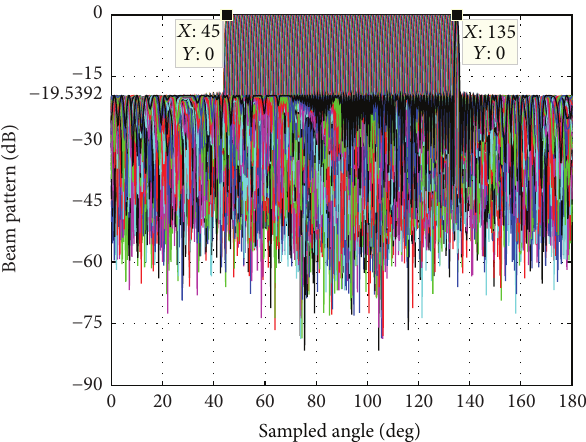
Figure 5: Beam pattern by only optimizing elements’ positions.